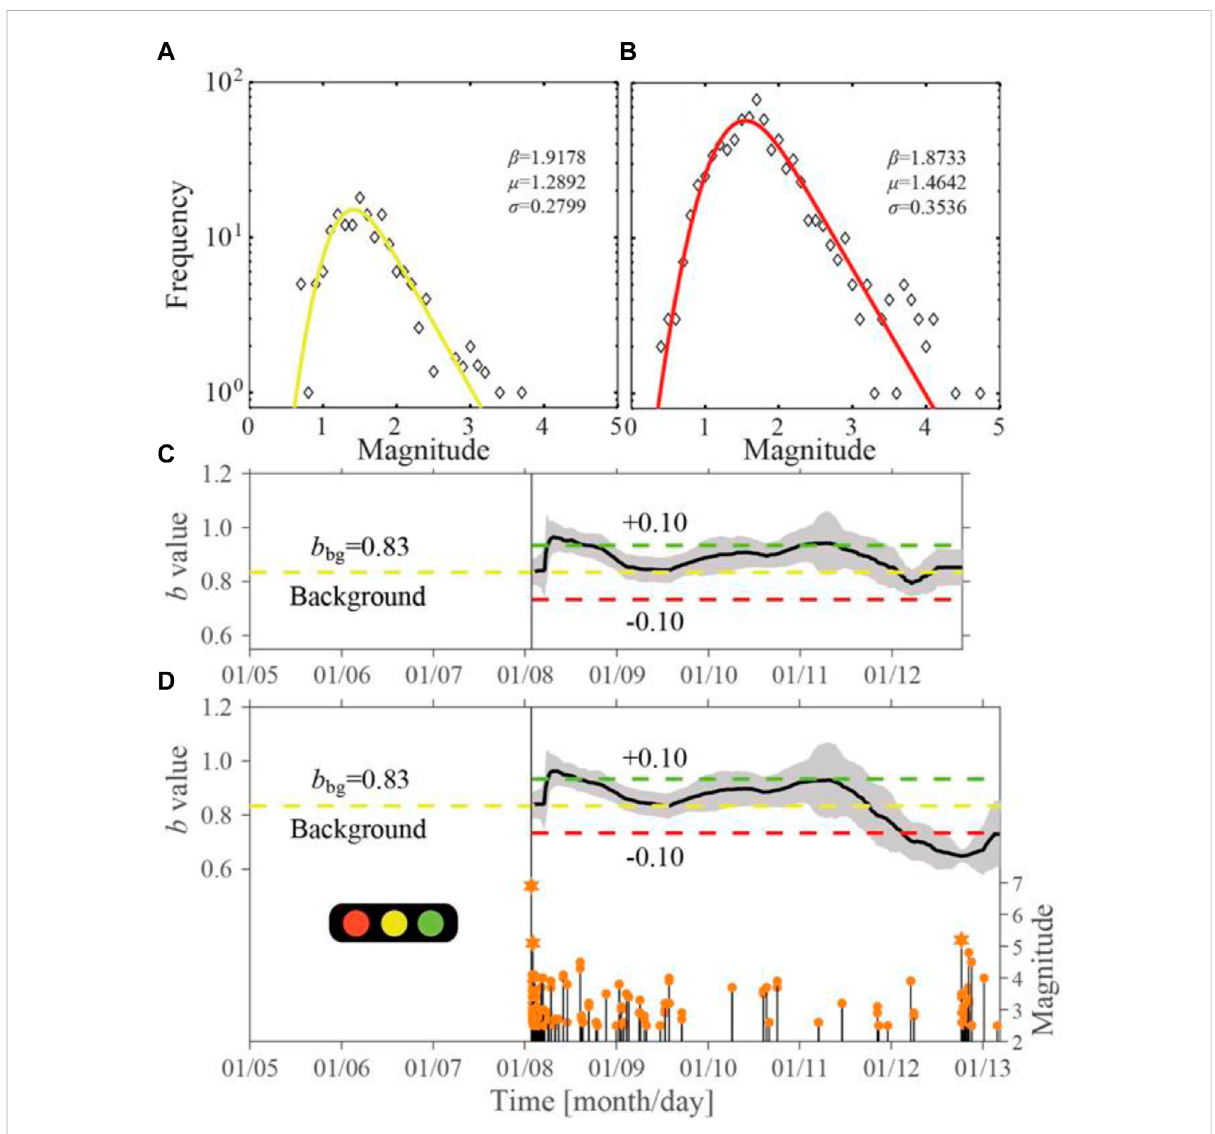
FIGURE 7 Characteristics of the b- value evolution for the 8 January 2022 Menyuan M S 6.9 earthquake sequence and SATLS settings. (A,B) Magnitude – frequency distribution (FMD) and the fi tting results of the OK1993 model. They correspond to the background earthquake sequence (1970.01.01~2022.01.08) and aftershock sequence (2022.01.08~2022.01.12), respectively. The diamonds denote the FMD of the events. The solid curveindicatesthe fi ttingresults oftheOK1993 model, andtheactualparametersaremarkedineachsubgraphintheorderof β , μ , and σ . (C) b- value of time series obtained using the events immediately before the strong aftershock (2022.01.08~2022.01.12). (D) b- value of time series calculated using the events between the main shock and the time after the strong aftershock (2022.01.08~2022.01.13). The yellow dotted line indicates background value b bg (yellow threshold), the red dotted line denotes the red threshold (0.1 lower than the background value), the green dotted line represents the green threshold (0.1 higher than the background value), and the magnitude – time distribution ( M - t ) of the earthquake sequence is